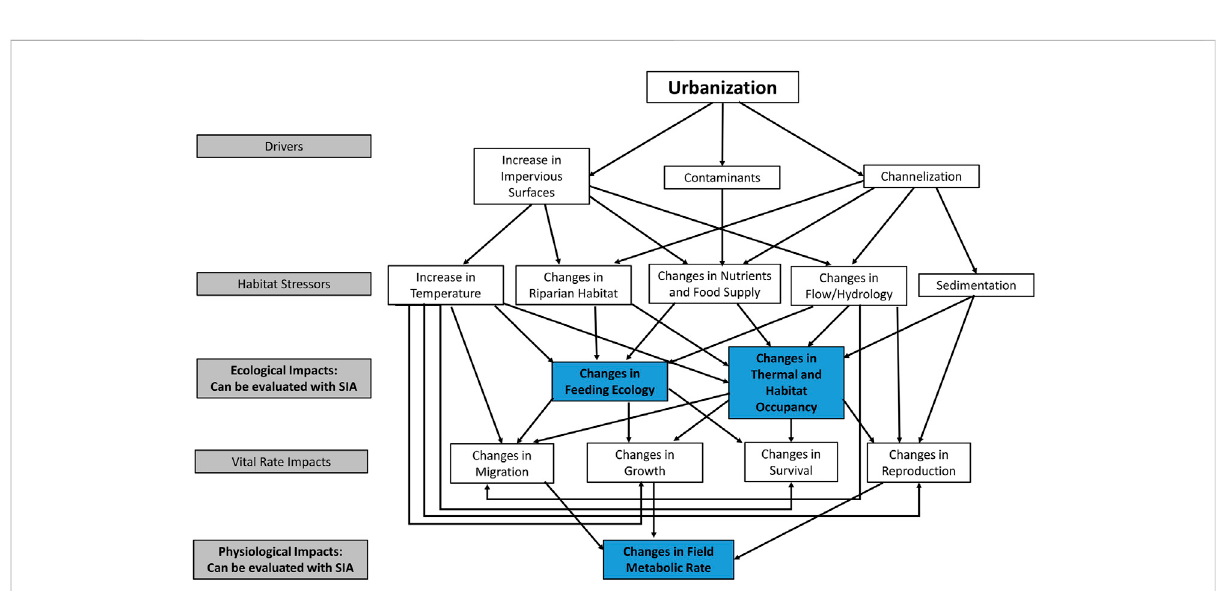
FIGURE 1 Multifactorial conceptual pathways for urbanization effects on freshwater fi sh. Aspects that can be directly evaluated using stable isotope analysis are shown in blue. Aspects more generally assessed using methods aimed at quanti fi cation of vital rates are shown in white. Links and feedbacks between stressors were not represented to enhance